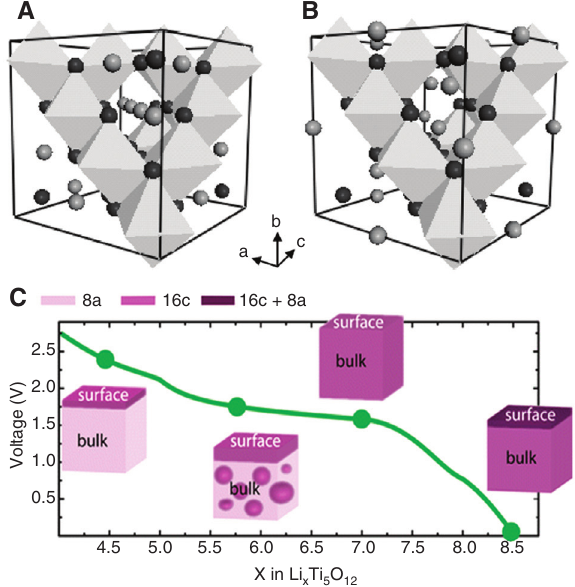
Ti O spinel structure with Li Figure 2 (A) Perspective view of Li 4 5 12 occupying the tetrahedral 8a sites. (B) Perspective view of Li rock-salt structure with Li occupying the octahedral 16c sites. (The polyhedrons indicate [Li Ti ]O units, dark spheres represent 1/6 5/6 6 oxygen, and light spheres represent lithium) (C) A typical discharge curve of Li Ti O . (A) and (B) are reprinted with permission from 4 5 12 Ref. [22]. © 2008 American Chemical Society. (C) is reprinted with permission from Ref. [23]. © 2012 American Chemical Society.